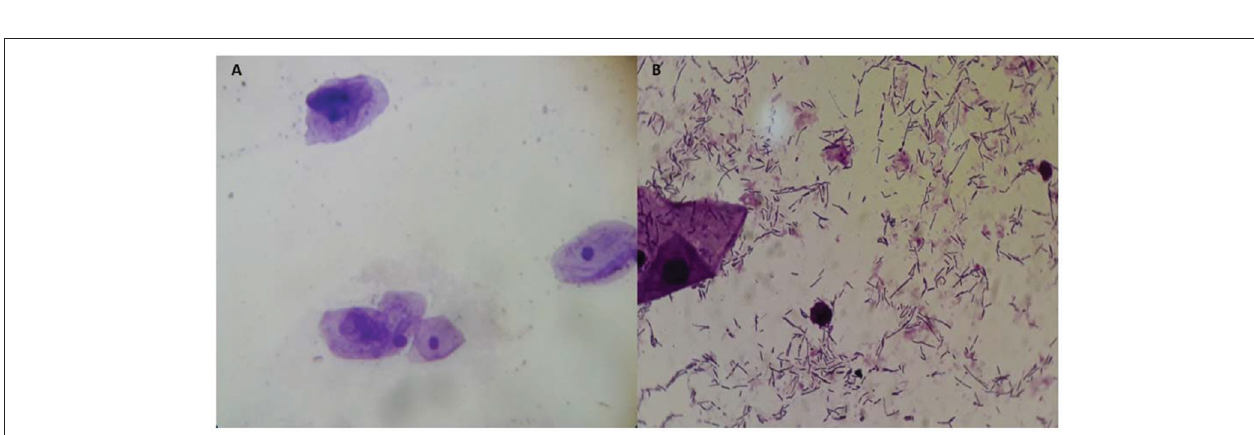
FIGURE 1 | The electrode is parallel and lightly touching the mucosa and the subsequent microablations. Adapted from Sarmento et al. (7). (A) Radio frequency application. (B) Vaginal mucosa after radiofrequency application.